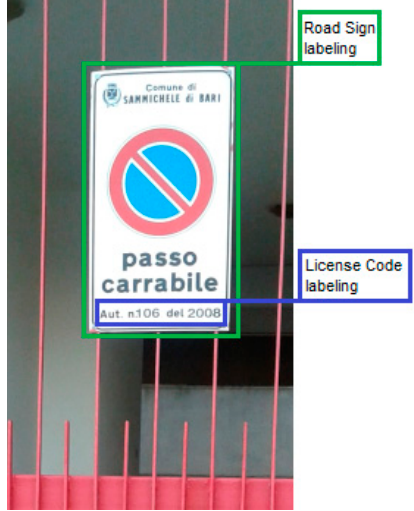
Figure 4. The bounding boxes drawn by a human annotator to build the ground truth image dataset.